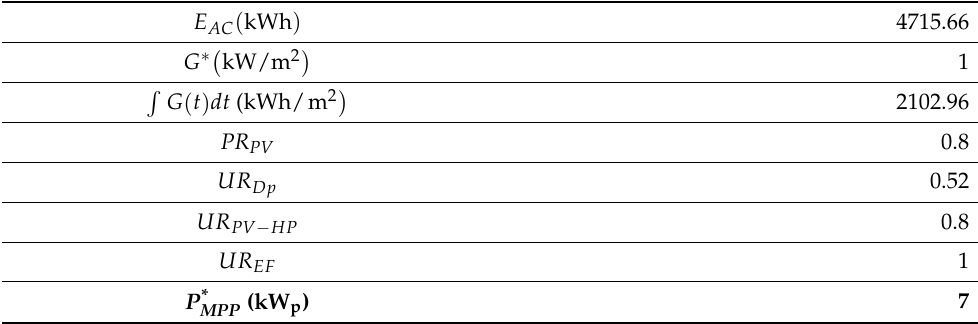
Table 3. Input values used for the sizing of the PV generator of the PVDS and the corresponding PV peak power that needs to be